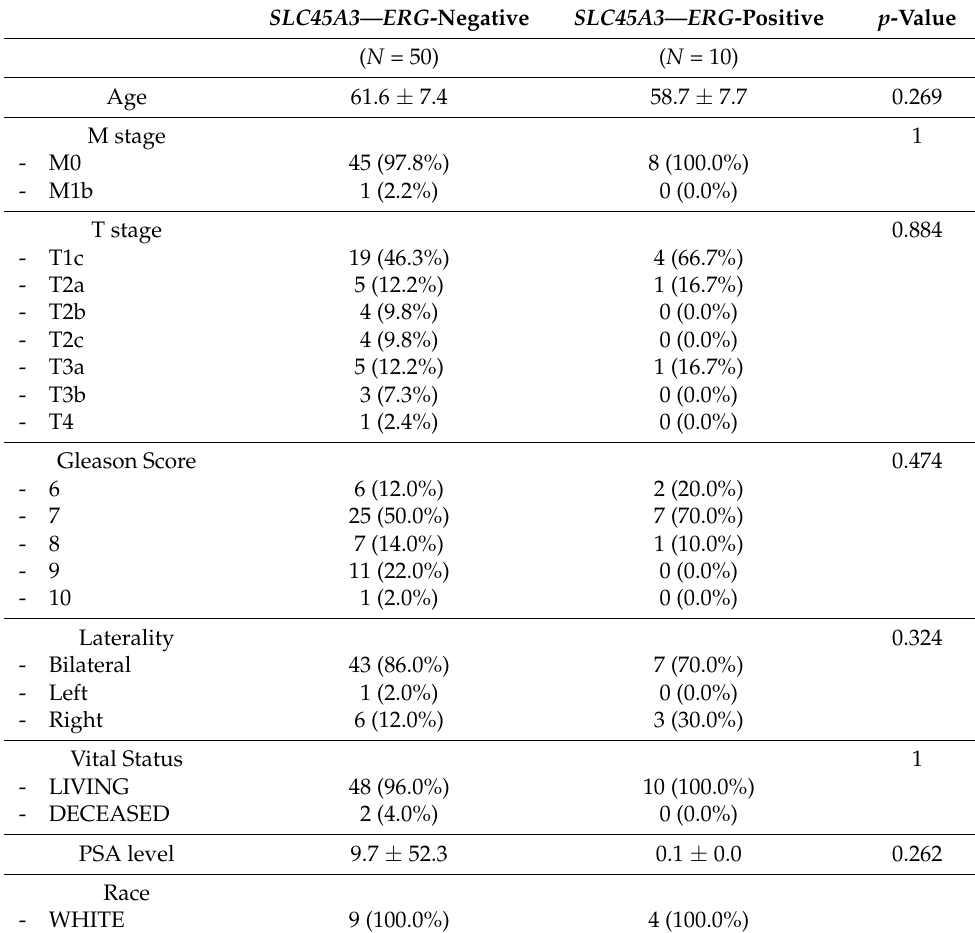
Table 1. Patient characteristics of S:E fusion-positive and fusion-negative patients. SLC45A3—ERG -Negative SLC45A3—ERG -Positive p -Value ( N = 50) 61.6 ±